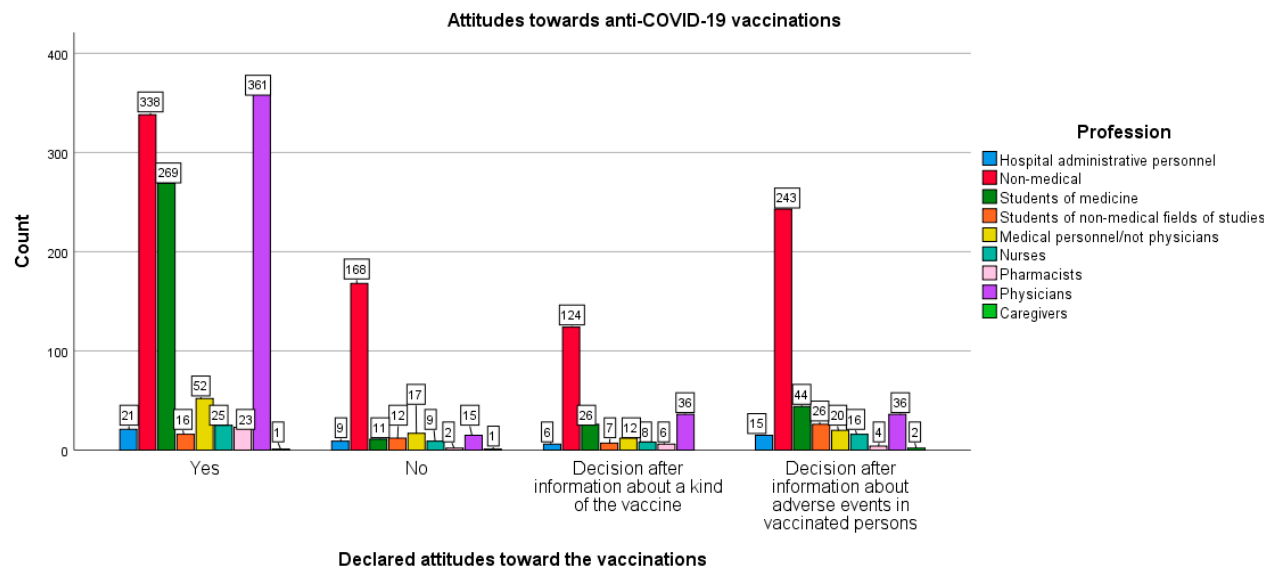
Figure 4. Declared attitude towards the coronavirus disease 2019 (COVID-19) vaccination in the particular profession groups.